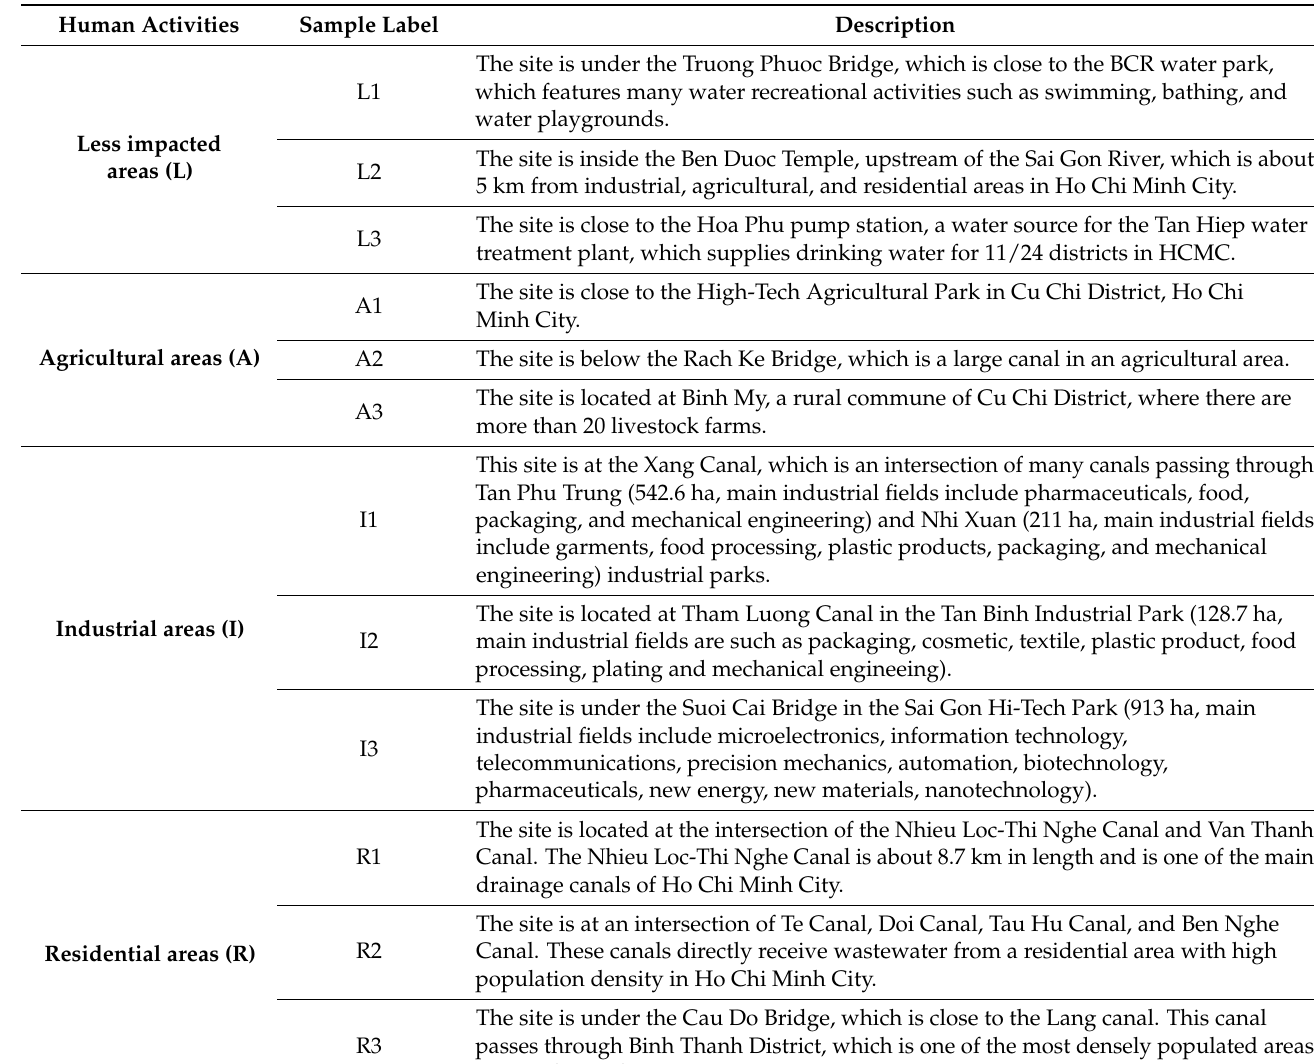
Table 1. Description of all sampling sites in the Sai Gon